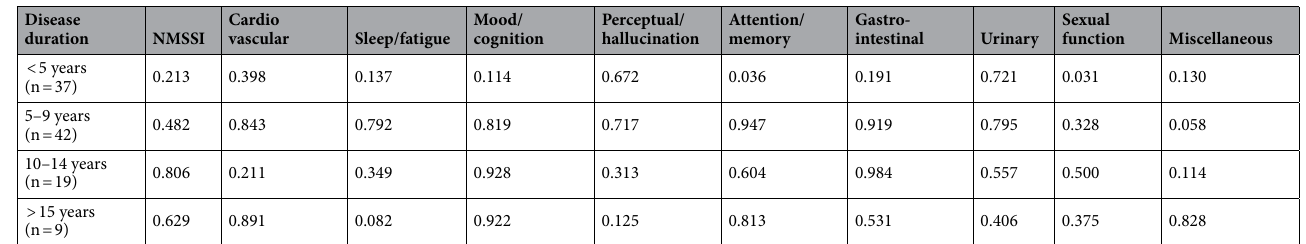
Table 3. Evolution of NMS severity in 2 years in groups of different disease duration. We compared the repeated test in 2 years in 107 patients. Data were obtained using the Wilcoxon signed-rank test, and P values are shown. P < .017 indicates